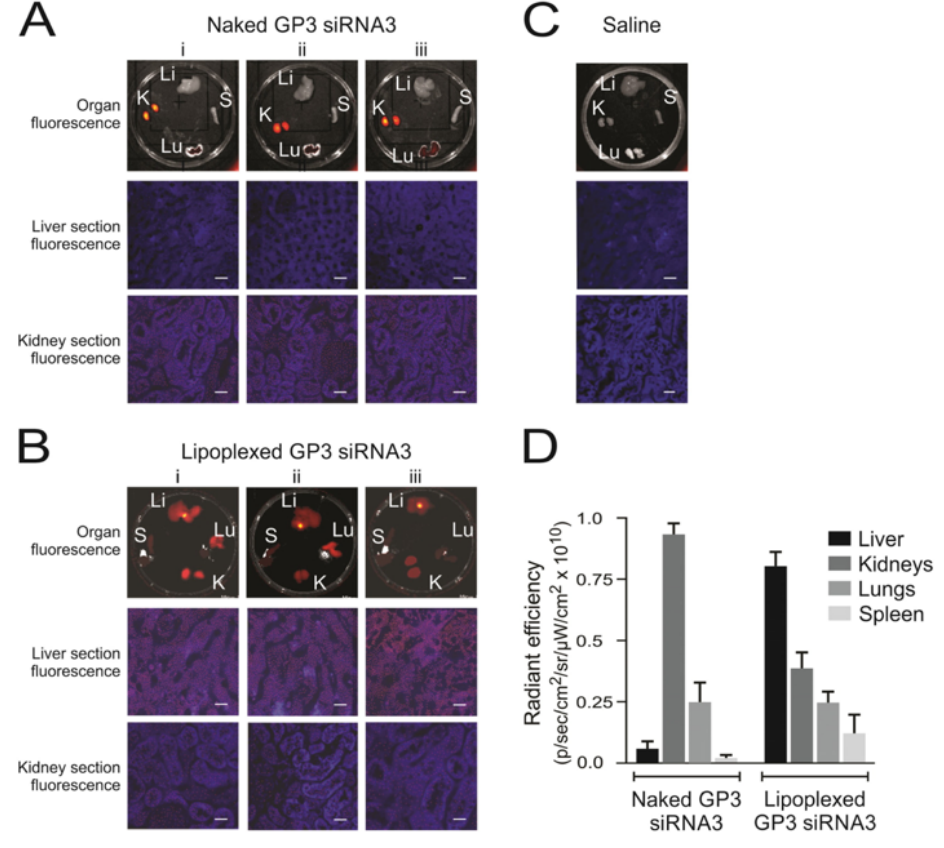
Figure 3. Biodistribution of siRNAs in HBV transgenic mice. Representative fluorescence images obtained from samples harvested 10 min after injection of lipoplexes containing Alexa Fluor 750-labeled siRNAs. Three mice (i–iii) received intravenous injection of the uncomplexed naked labeled siRNA ( A ), and three mice (i–iii) received labeled siRNA within polyglutamate-containing lipoplexes ( B